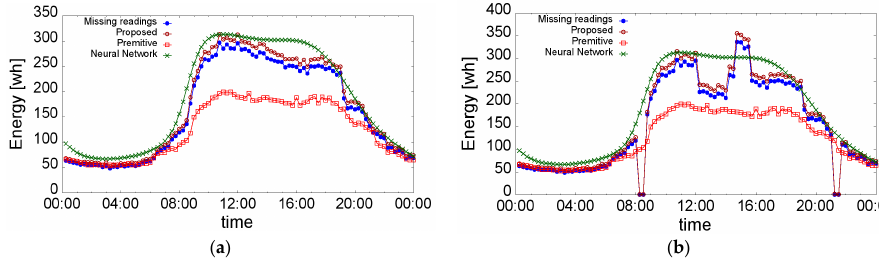
Figure 7. Missing load curves recorded during an entire day and estimation results at Node(2): ( a ) Load without outliers; ( b ) Load with outliers.